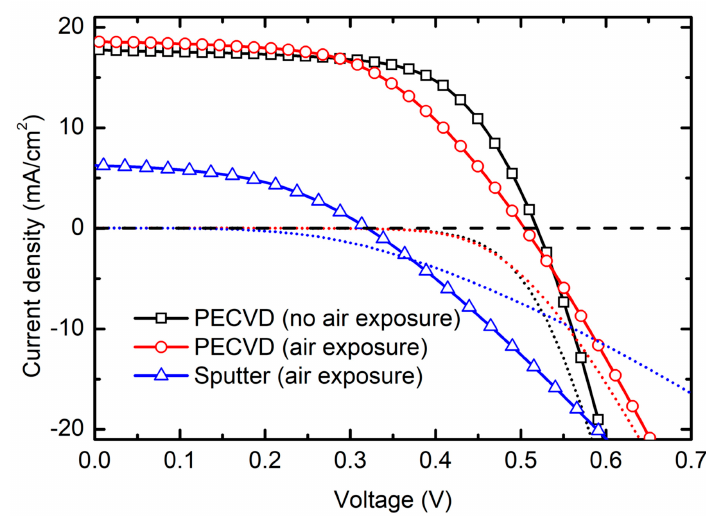
Figure 3. Current–voltage (J–V) measured under 100 mW / cm 2 simulated AM1.5G irradiation and in the dark for the highest efficiency n-i-p devices incorporating a PECVD absorber without vacuum break (black squares, black dotted line), PECVD absorber with vacuum break before and after intrinsic layer deposition (red circles, red dotted line), and RF magnetron sputtered absorber also with vacuum break before and after intrinsic layer deposition (blue triangles, blue dotted line).